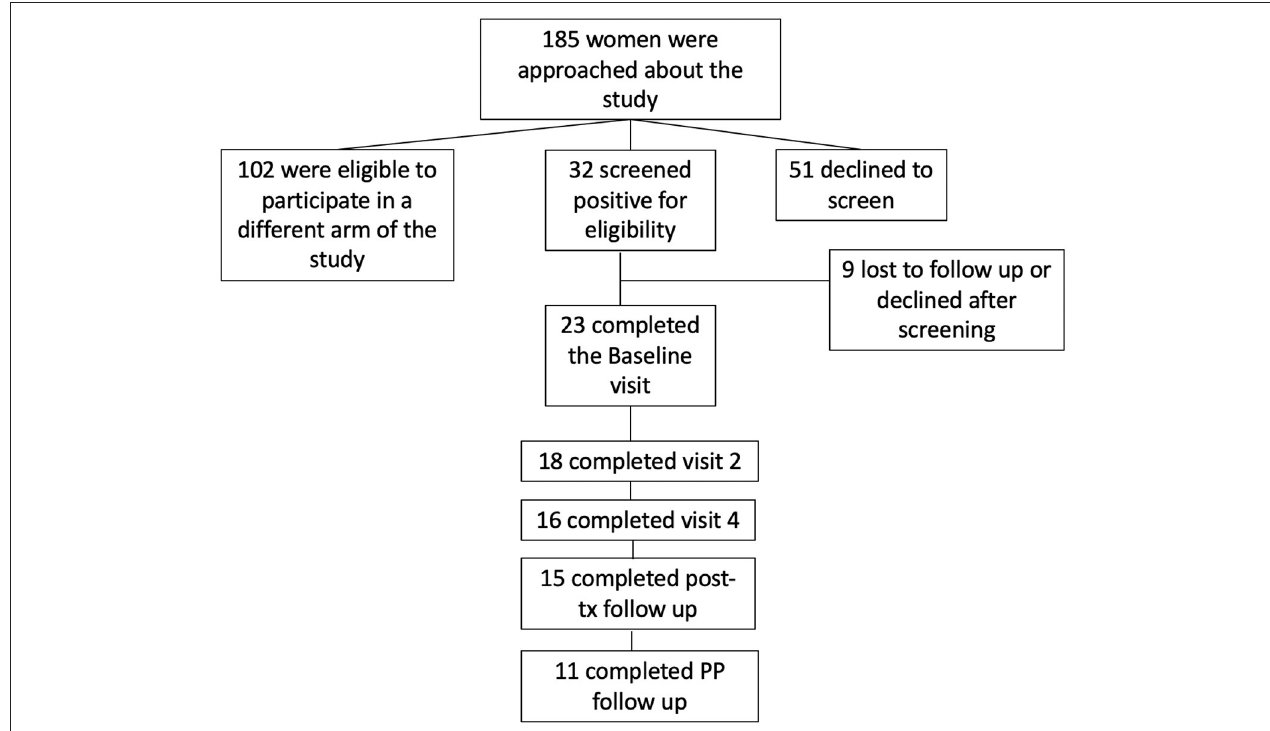
FIGURE 1 | Participant enrollment